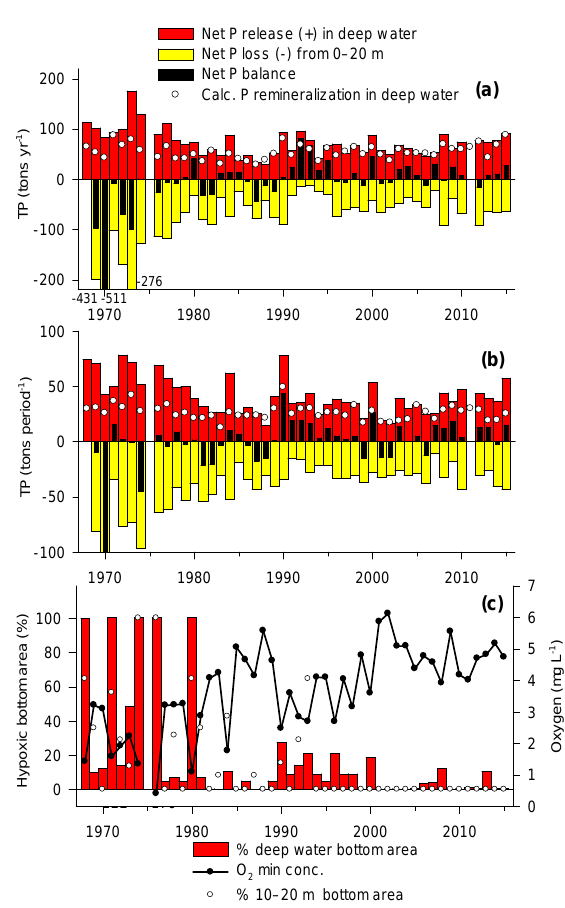
Figure 6. Internal total phosphorus (TP) fluxes and oxygen (O 2 ) conditions. (a) Annual net TP release in deep layer ( > 20m), annual net TP loss from 0–20m, net TP balance for whole water mass, and calculated P remineralization from organic matter (from modelled O 2 consumption). Positive net TP balance indicates net TP release from sediments to water mass and negative balance indicates net TP loss from water to sediments. (b) As in (a) but net TP release in deep layer ( > 20m) for July–October and net TP loss from 0 to 20m in March–May. (c) Minimum volume-weighted O 2 concentration in deep water and maximum percent hypoxic (O 2 < 2mgL − 1 ) bottom